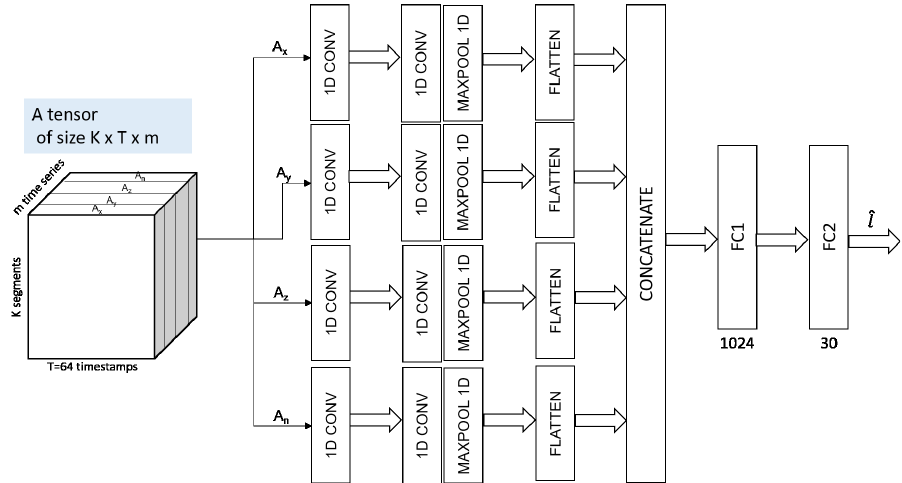
Figure 7. The three-dimensional tensor representation of the multivarite time series data is the input of the convolutional neural network pipeline of our